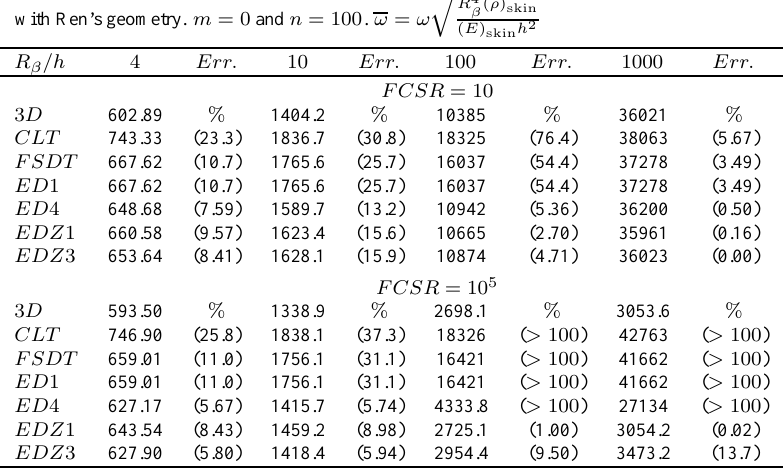
Table 5 Comparison of various theories to evaluate the fundamental frequency amplitude for the shell with Ren’s geometry. m = 0 and n = 100 . ω = ω